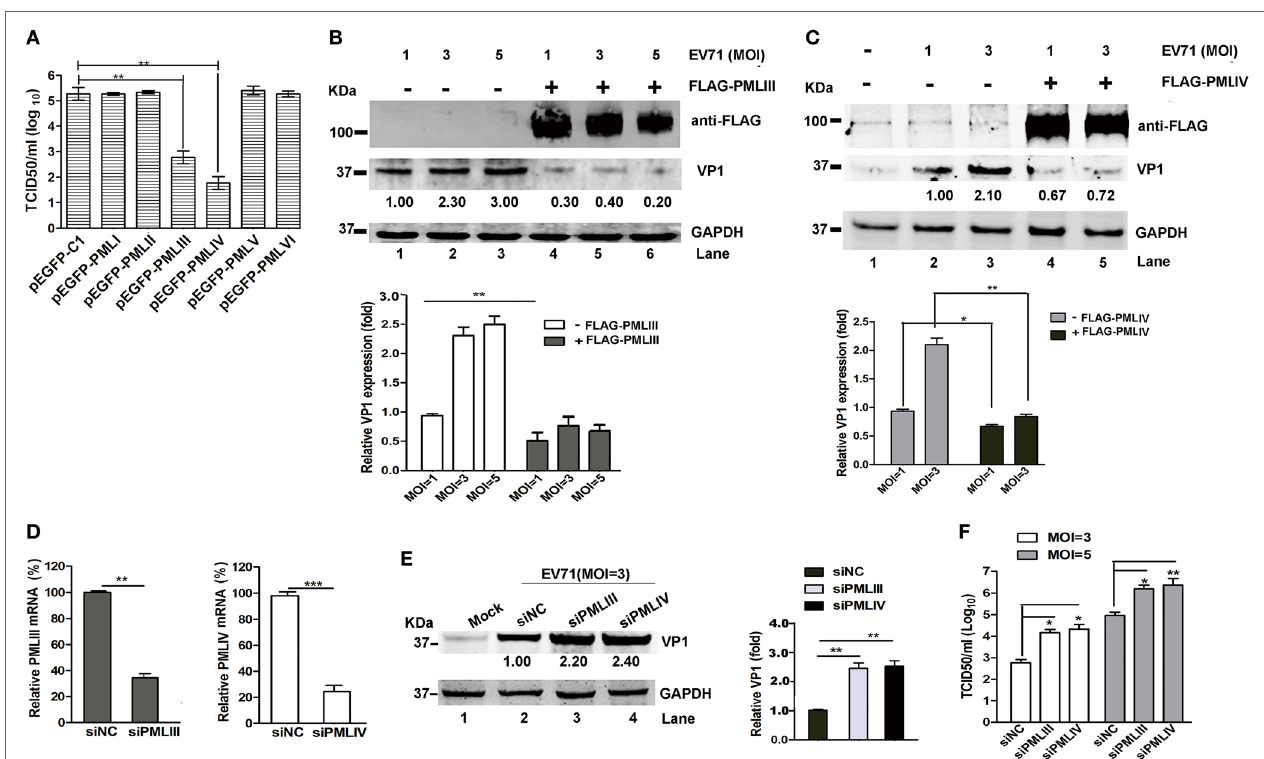
FigUre 3 | PMLIII and PMLIV isoforms conferred resistance to enterovirus 71 (EV71) infection. (a) HeLa cells were transfected with plasmids expressing individual promyelocytic leukemia (PML) isoforms (pEGFP-PMLI to pEGFP-PMLVI) or a control plasmid (pEGFP-C1). At 24 h after transfection, the cells were infected with EV71 at a multiplicity of infection (MOI) of 5. At 24 h post-infection (p.i.), the virus in the culture supernatants was determined by performing a standard plaque assay. The presented values are the means of triplicate determinations and the SEs. The asterisks indicate significant differences (** p < 0.01). (B,c) PML − / − HeLa cells were transfected with the plasmids FLAG-PMLIII (B) , FLAG-PMLIV (c) , or pCDNA3.1 as a control for 24 h and then infected with EV71 at an MOI of 1, 3, or 5 (B) or an MOI of 1 or 3 (c) . At 24 h p.i., the cell extracts were analyzed by performing a Western blot analysis using an antibody specific for FLAG, VP1, or GAPDH. Densitometry was performed, the values from three independent experiments were averaged, and the data are expressed as the fold change in VP1 expression. The VP1 expression in HeLa cells infected with EV71 at an MOI of 1 is assigned a value of 1.00. (D) HeLa cells were transfected with small interfering RNAs (siRNAs) specific for PMLIII or PMLIV or a non-targeting siRNA (siNC) as a control. At 24 h after transfection, the knockdown efficiency of the mRNA of PMLIII or PMLIV was determined by performing qRT-PCR and normalized to the GAPDH mRNA level in the HeLa cells. Data from three independent experiments were averaged and are shown as the fold change in PML expression normalized to siNC. siNC treatment is assigned a value of 100%. (e) HeLa cells were transfected with siRNAs specific for PMLIII or PMLIV or a non-targeting siRNA (siNC) for 24 h and then infected with EV71 at an MOI of 3 for 24 h. The cell extracts were determined by performing a Western blot analysis using antibodies specific for VP1 and GAPDH. Densitometry was performed, the values from three independent experiments were averaged, and the data are expressed as the fold change in VP1 expression normalized to siNC. siNC treatment at an MOI of 3 is assigned a value of 1.00 (** p < 0.01). (F) HeLa cells were transfected with siRNA specific for PMLIII or PMLIV or a non-targeting siRNA (siNC) for 24 h and then infected with EV71 at an MOI of 3 or 5 for 24 h. The cell culture supernatants were measured by performing a TCID 50 assay using Vero cells (* p < 0.05, ** p <